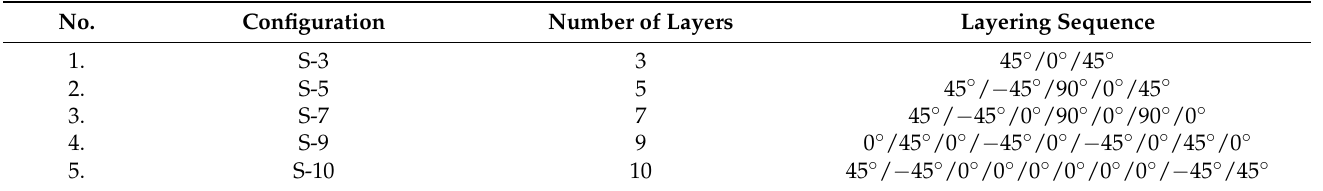
Table 6. Five configurations of pGFRP composite cross arms. Reproduced from Ref.